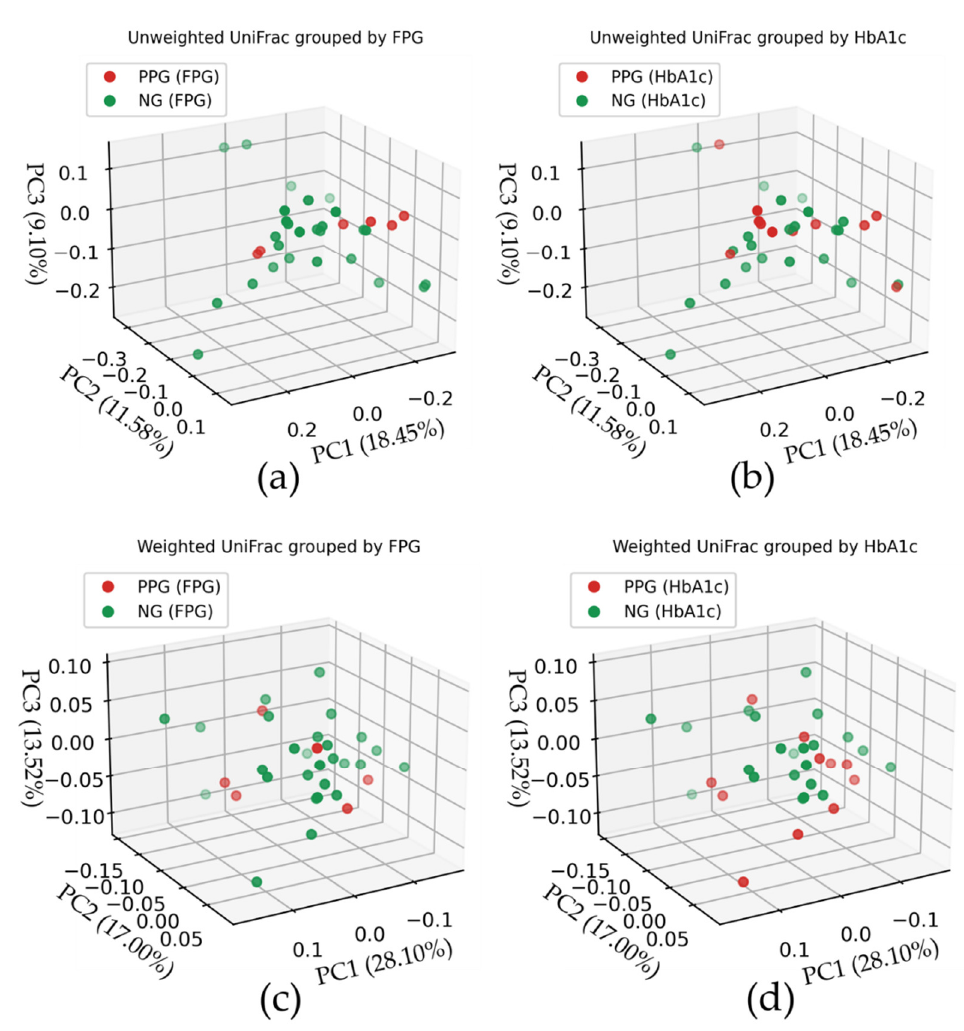
Figure 2. Principle coordinate analysis (PCoA) based on the unweighted (top panels) and weighted (bottom panels) UniFrac distance matrices. The red and green dots represent the PPG and NG groups, respectively. The colored symbols are shaded according to their positions on the 3D plot. The top panels ( a , b ) show the PCoA of unweighted UniFrac indices, while the